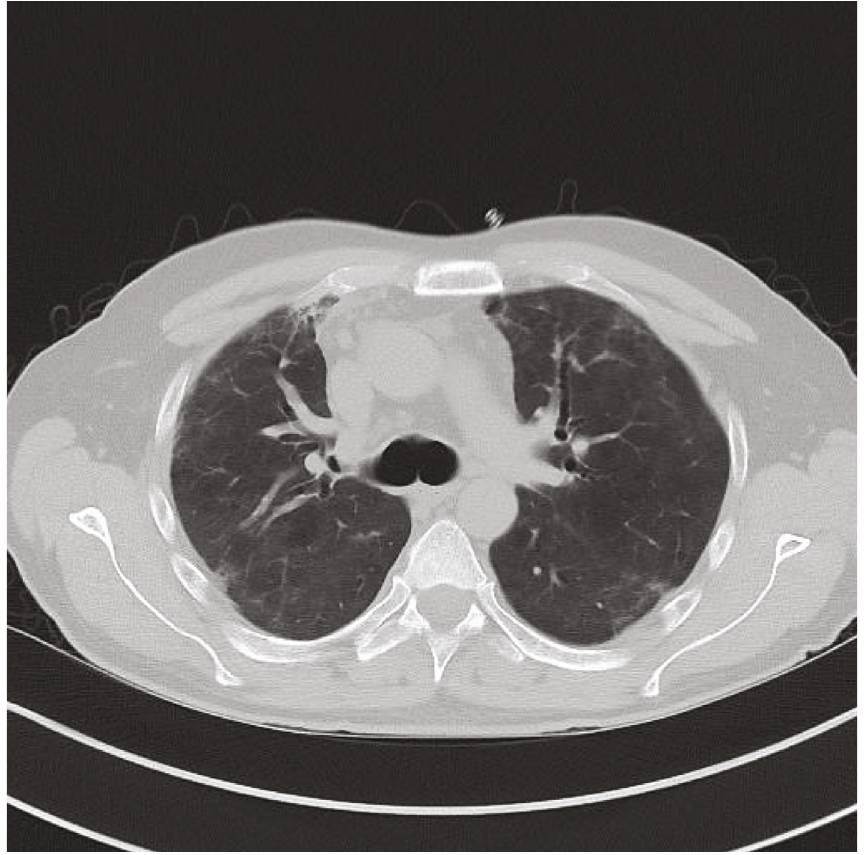
Figure 2: Chest CT-scan 31 days after ECMO implantation, the same level as Figure 1. The pneumothorax and pneumomediastinum completely abated, and the ground glass opacities profoundly